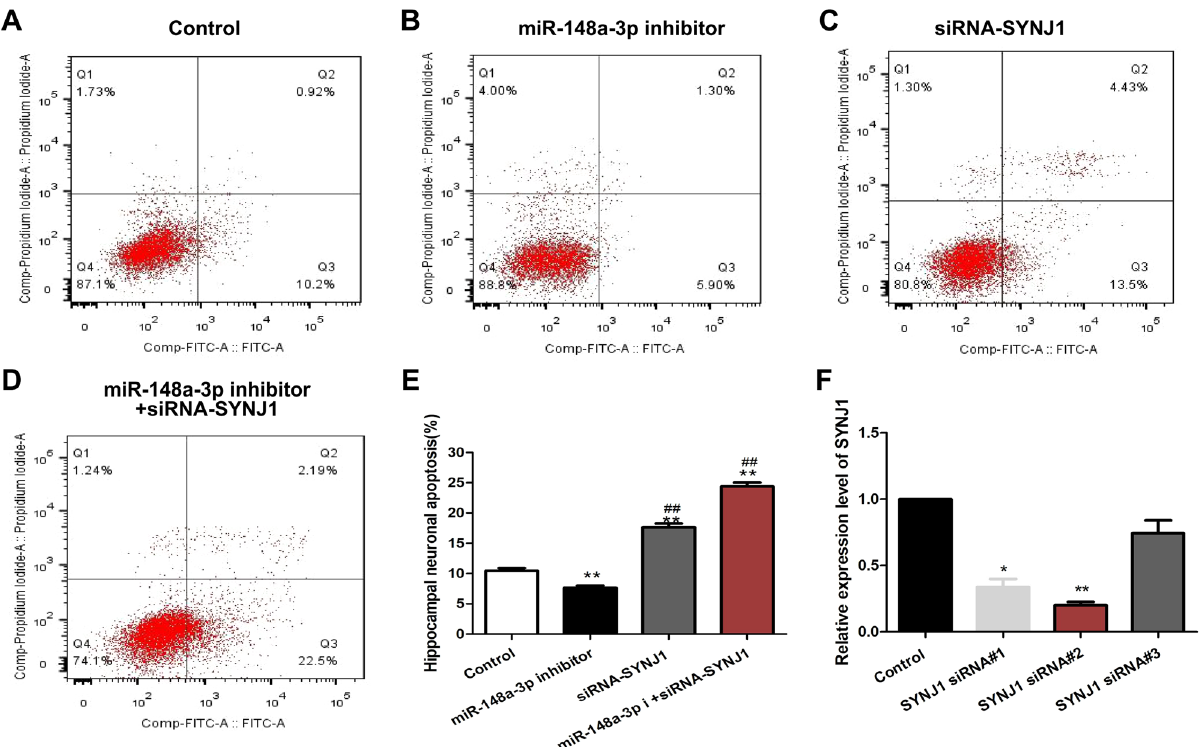
Figure 8. miR-148a-3p regulation of hippocampal neuron apoptosis through targeting SYNJ1. ( A – D ) Hippocampal neuron apoptosis using flow cytometry. H19-7 hippocampal neuronal cells were incubated with 100 µM KA for 48 h. miR-148a-3p inhibitor and siRNA-SYNJ1 were added to the culture 4 h prior to KA treatment. Cells were collected and stained with Annexin V and propidium iodide (PI) and then examined by flow cytometry. ( E ) Hippocampal neuron apoptosis rate. Results are shown as the mean ± S.E.M. and represent three independent experiments. **P < 0.01 vs. control group; ## P < 0.01, vs. miR-148a-3p inhibitors group. (F) Comparison of the effects of three different SYNJ1 siRNAs. *P < 0.05, SYNJ1 siRNA#1 vs. control group; **P < 0.01, SYNJ1 siRNA#2 vs. control group.